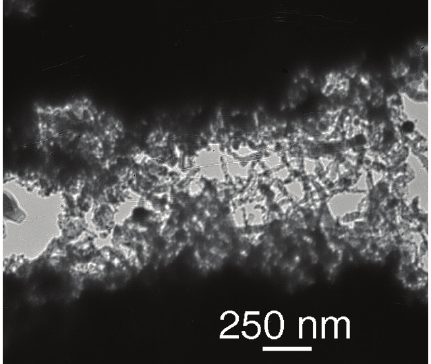
Figure 2: TEM image of carbon nanotube/metallic particles hybrids inside of pressed stainless steel pellets. As an example, metallic particlesagglomerationsofPt(blackflakes)withafewnanoparticles (black circles) are